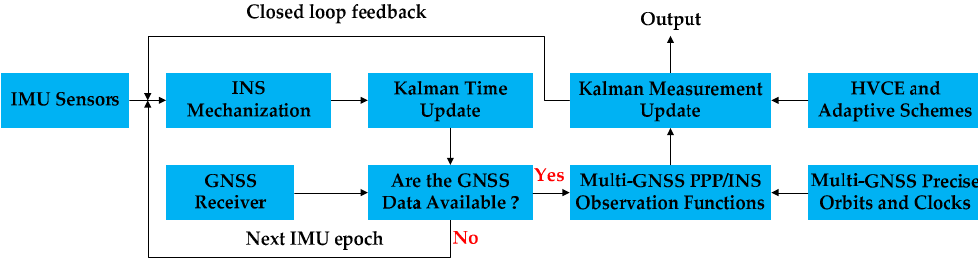
Figure 1. Implementation of the Helmert variance component estimation (HVCE) based adaptive Kalman filter for the multi-GNSS PPP/INS tightly coupled integration.